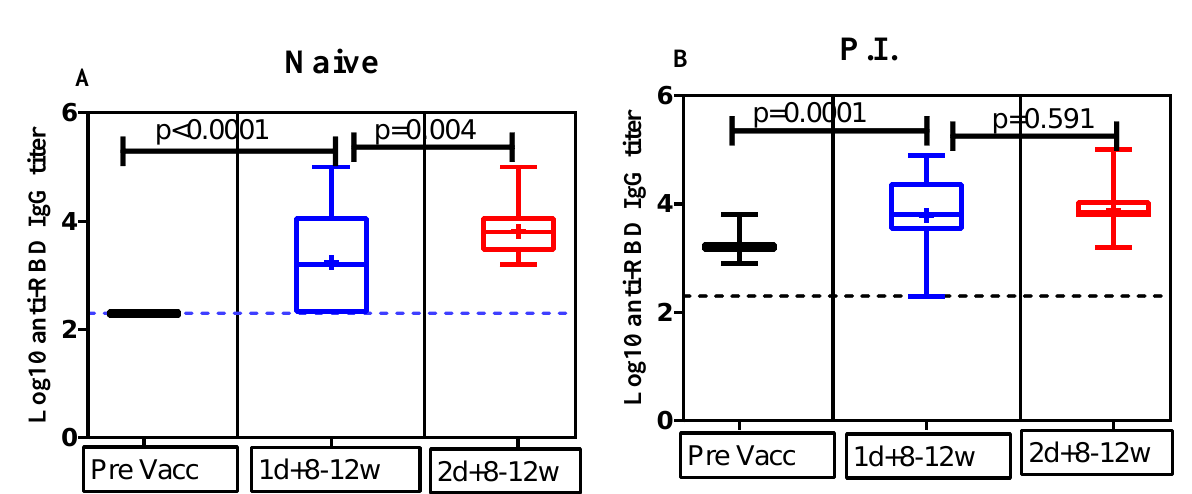
Figure 2. Analysis of the ChAdOx1 nCoV-19 vaccine-induced antibody response in naïve and previously infected (P.I.) participants profile at different time points. Comparison of mean log10 anti-RBD IgG titers between naïve ( A ) and P.I. ( B ) participants across different time points before and after vaccination. Horizontal bars represent the means with 95% CIs of anti-RBD IgG titer levels (transformed to Log10 value) within the indicated groups. The broken line denotes the assay detection limit. Unpaired and non-parametrical Mann–Whitney test was used to compare the mean differences in log10 anti-RBD IgG titers for each time point of serum collection. A p -value <0.05 was considered statistically significant, and p >0.05 was considered non-significant (ns). Pre Vacc = baseline or prevaccination; 1d + 8–12w = 8–12 weeks after the first dose; 2d + 8–12w = 8–12 weeks after the second